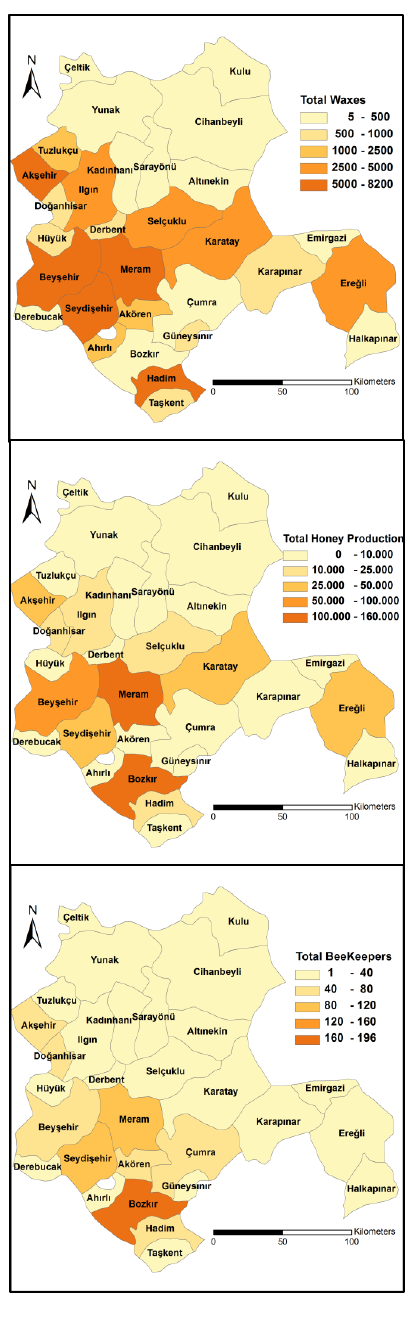
Figure 4. TUIK 2015 statistics for